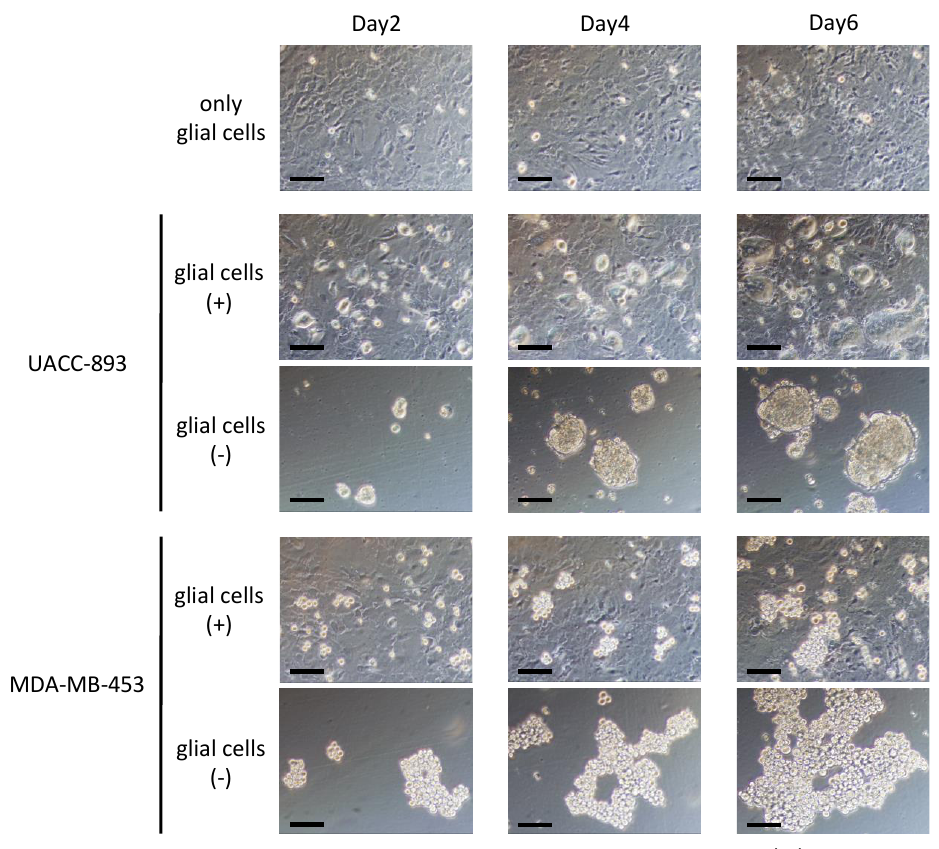
Figure 3. Coculture of HER2-positive breast cancer cell lines and murine glial cells. Pictures of two RG cell lines cultured in serum-free medium with or without glial cells for six days are shown (n = 3). Pictures were taken every other day. Scale bars = 100 µm.